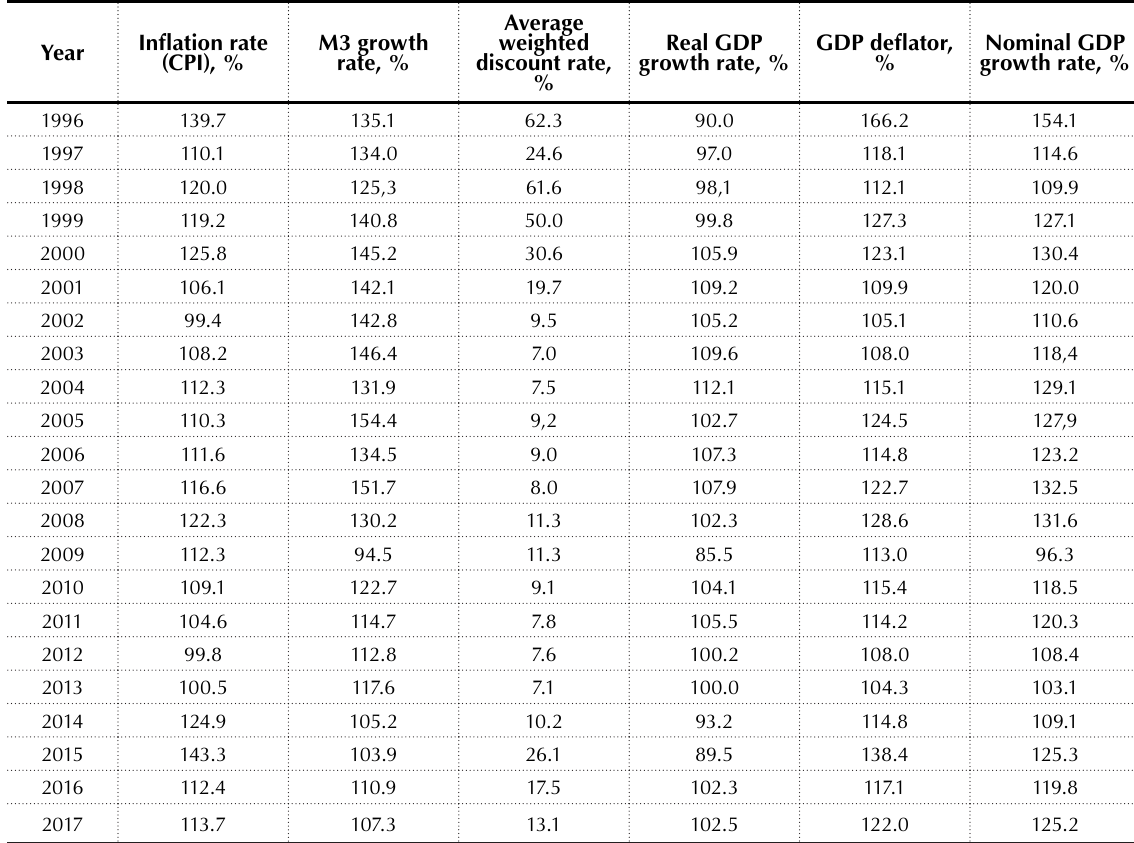
Table 2. Dynamics of the main macroeconomic and monetary indicators in Ukraine in 1996–2017 Source: Calculated by the authors based on the NBU